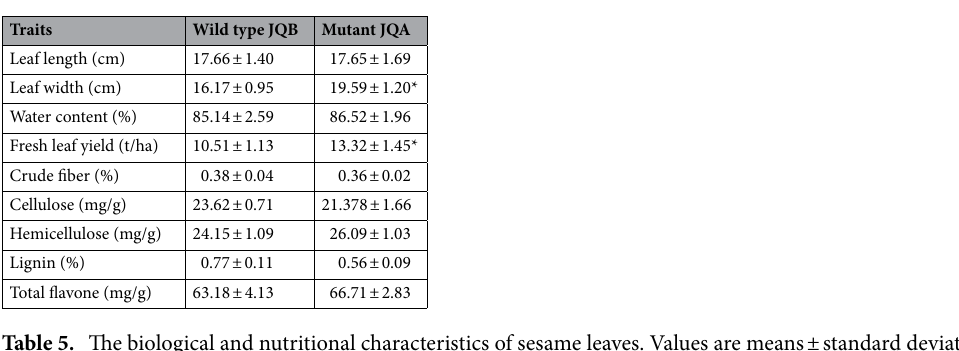
Table 5. The biological and nutritional characteristics of sesame leaves. Values are means ± standard deviation ( n = 3). Data in the same row followed by * and ** are significantly ( P < 0.05) and very significant ( P < 0.01) different,